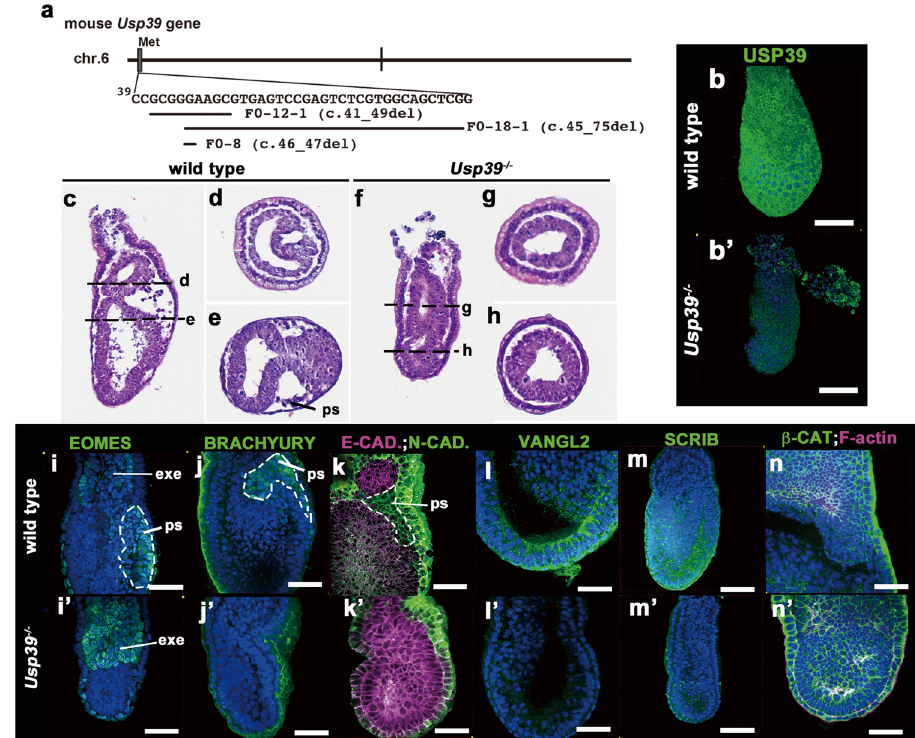
Fig. 4 Generation and phenotype analyses of Usp39 -de fi cient embryos. a Schematic for deletion of the Usp39 coding region generated by a CRISPR/ Cas9 system. The line F0-12-1 deletes protein coding sequences corresponding to the 41th to 49th cDNA sequence, F0-18-1 deletes the 45th to 75th cDNA sequence, and F0-8 deletes the 46th to 47th cDNA sequence, respectively. All three lines are considered to be frameshifted null alleles. b , b ′ , i – n ′ Immunohistochemistry of whole-mount wild-type ( b , i – n ) and Usp39 − / − ( b ′ , i ′ – n ′ ) embryos at E6.5. Ubiquitin-speci fi c protease 39 (USP39) (green; b , b ′ ), EOMESDERMIN (EOMES; green; i , i ′ ), BRACHYURY (green; j , j ′ ), E-/N-cadherin (E-CAD.; (magenta), N-cadherin (N-CAD.; green; k , k ′ ), VANGL2 (green; l , l ′ ), SCRIB (green; m , m ′ ), β -catenin ( β -CAT; green), F-actin (magenta; n , n ′ ), and 4,6 ′ -diamidino-2-phenylindole (DAPI) (blue). c – h Morphological features of wild-type ( c – e ) and Usp39 − / − ( f – h ) embryos at E6.5. Sagittal ( c , f ) and transverse sections ( d , e , g , h ) stained with hematoxylin – eosin. Scale bars represent 100 μ m ( b , b ′ , c – h , m , m ′ ) and 50 μ m ( i – l ′ , n , n ′ (Figs. 4i – k ′ and S5). The anterior visceral endoderm markers, Hex , Lim1 , and Fgf8 transcripts, were expressed in normal positions (the presumptive anterior region) in Usp39 − / − embryos at E6.5, similar to those of wild-type embryos (Fig. S5a – c ′ ; arrowheads). An epiblast marker, Oct3/4 , was also observed normally in Usp39 − / − embryos (Fig. S5d, d ′ ). However, EOMESODERMIN and BRACHYURY